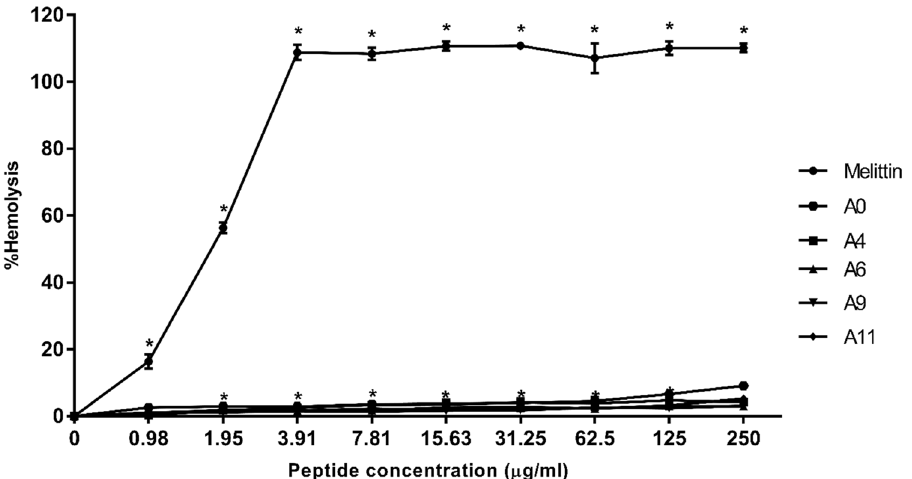
Figure 2. Hemolytic activity of A11 peptide and melittin against human red blood cells (hRBCs). The experiments were done in triplicate and the data are represented as the mean ± SD. The statistical analysis was performed using two-way ANOVA and Tukey’s test (p < 0.05). An asterisk (*) indicates a statistically significant difference when compared to that of the negative